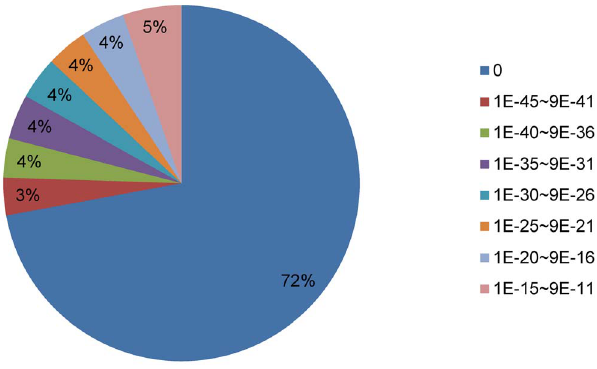
Figure 2. E-values of the cabbage loci annotation. We annotated 35,274 of 53,562 cabbage loci (65.9%) with 26,971 plant peptide sequences from the Phytozome database. The e-values of 25,472 of the cabbage loci were equal to zero, accounting for more than 72% of the annotated loci.